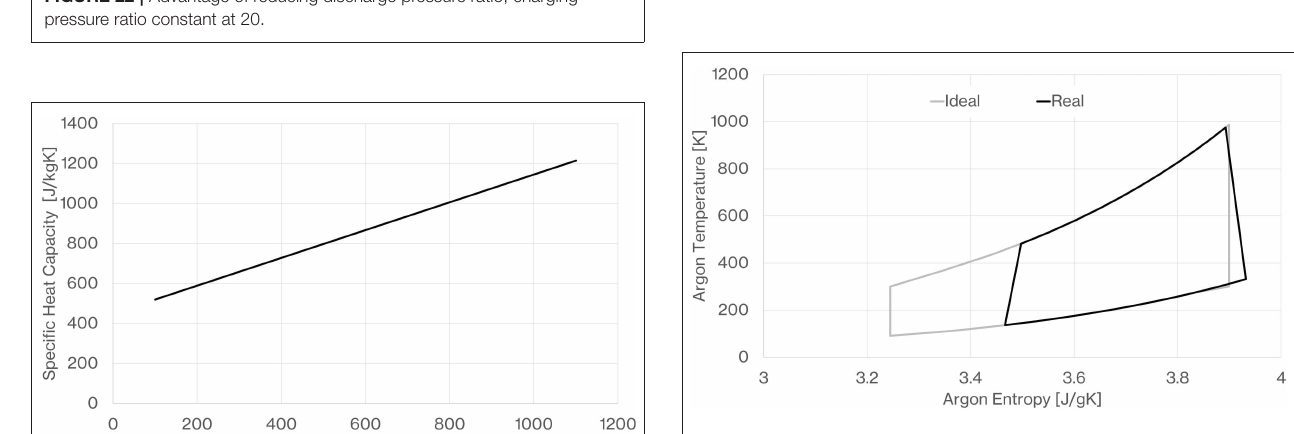
FIGURE 25 | Temperature-Entropy diagram of the simulated discharge cycle showing the effect of the calculated irreversible losses as compared to the ideal